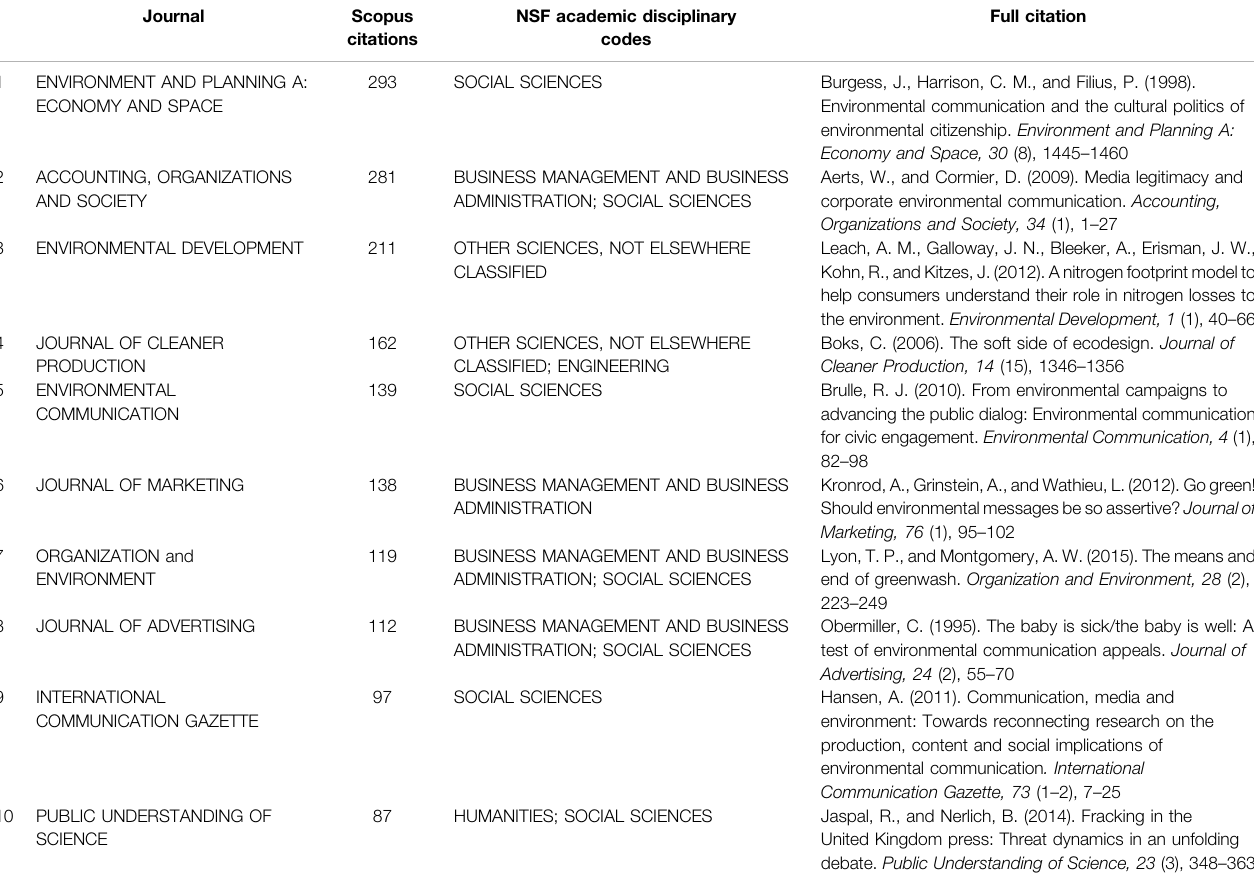
TABLE 1 | The 10 most cited environmental communication journal articles, 1970 – 2019 (Citations recorded from Scopus in July